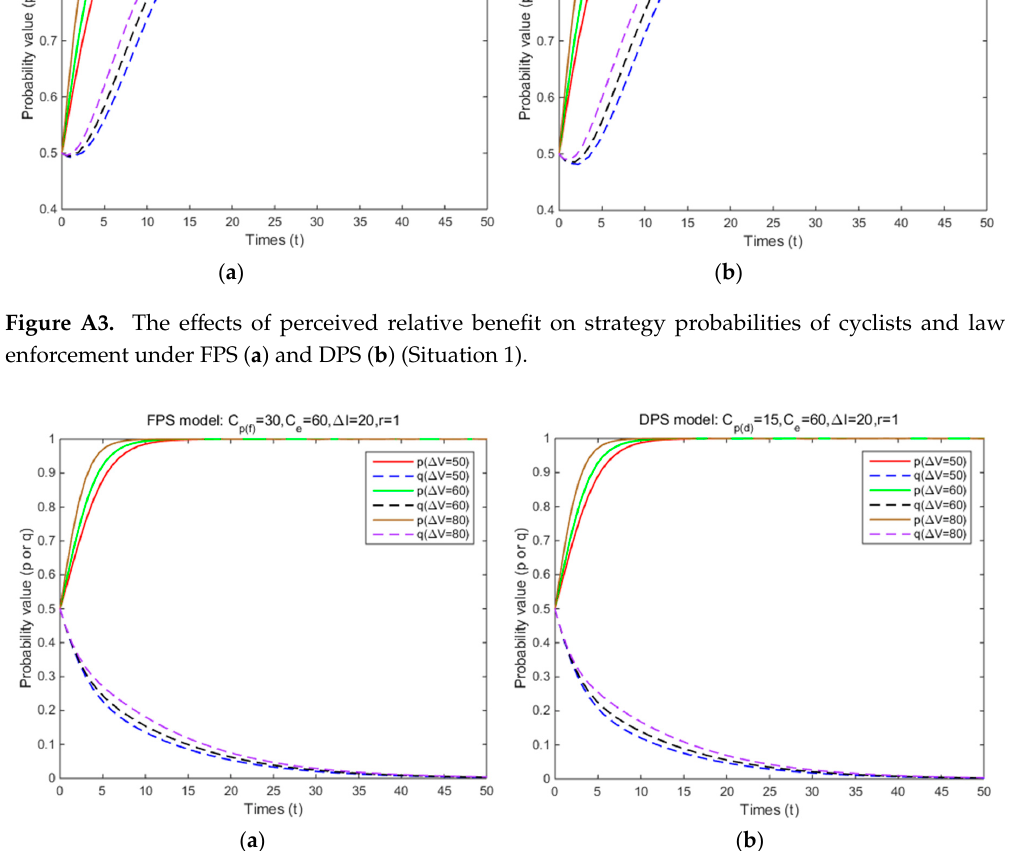
Figure A4. The effects of perceived relative benefit on strategy probabilities of cyclists and law enforcement under FPS ( a ) and DPS ( b ) (Situation 2).